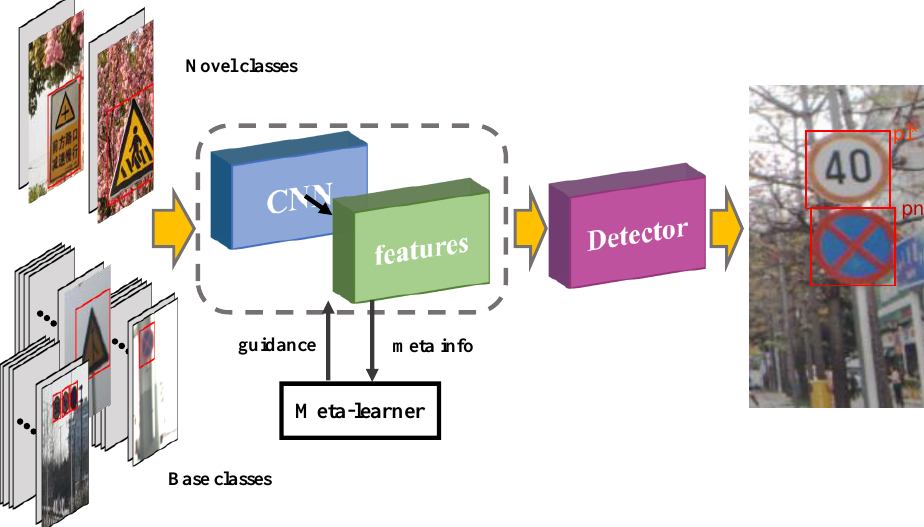
Figure 1. We aim to obtain a few-shot traffic sign detection model by training on the base classes with meta-learner guidance at image level; consequently, the model is able to detect novel objects on testing images with learning from a limited annotated sample.